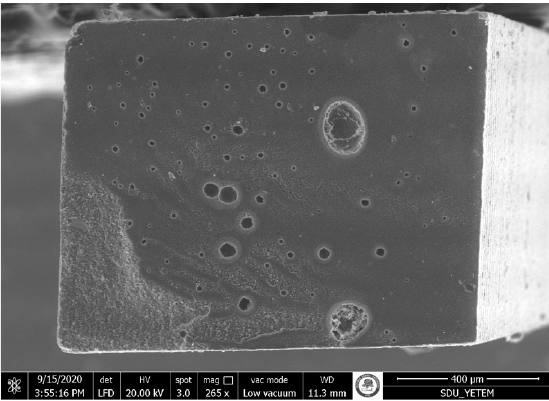
Figure 4. SEM photomicrograph of the fracture surface (aged composite side). The specimen was obtained from 1-year aging of bulk-fill resin composite, sandblasting, silane applied, Scotchbond Universal group. An adhesive failure pattern was revealed.